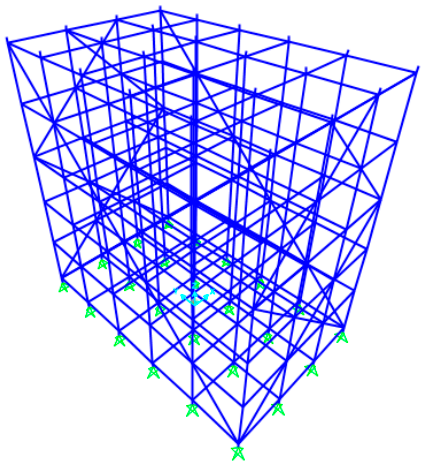
Figure 2. Analysis model of basic working condition.